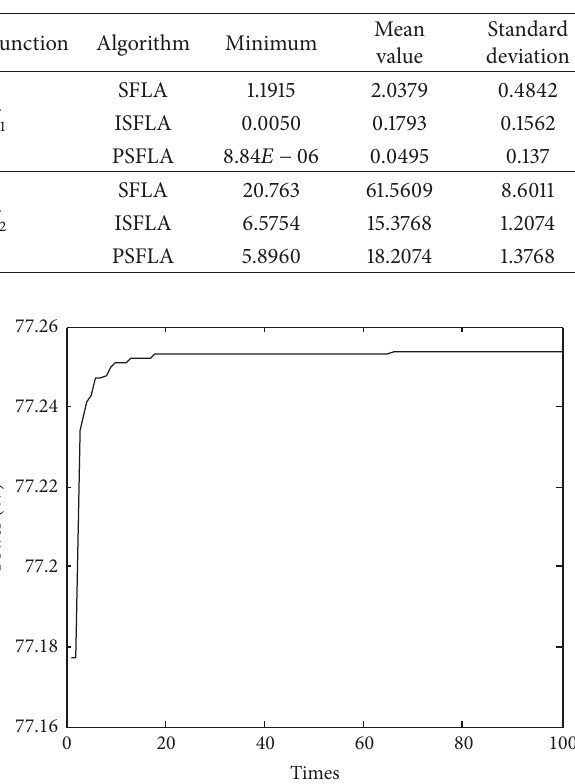
Table 1: The experimental results.